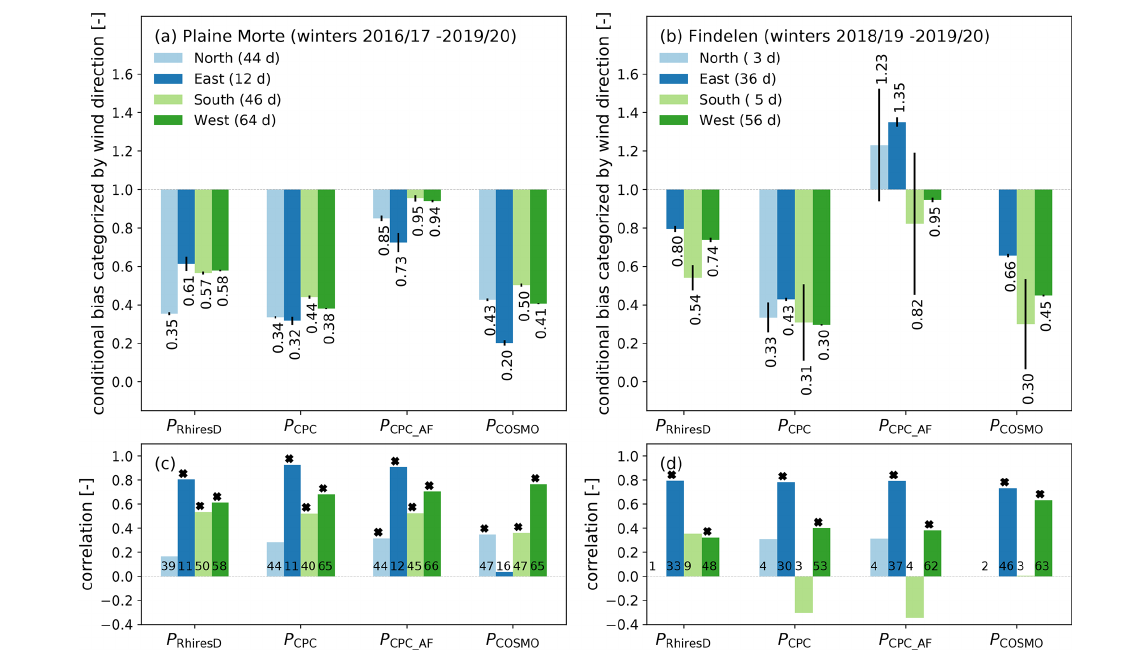
Figure 4. Conditional bias based on event-days and derived for the four main wind sectors on (a) Plaine Morte and (b) Findelen. The uncertainty is calculated with a leave-one-out cross validation. Numbers below the bars display the bias value in (a) and (b) . Panels (c) and (d) show the correlation between precipitation and SWE estimates during the event-days within the wind sectors for Plaine Morte and Findelen, respectively. Significant correlations ( α < 0 . 05) are marked with a star. Numbers at the bottom of the bars correspond to the number of event-days per category and precipitation data set. The evaluation is only shown if more than two event-days are